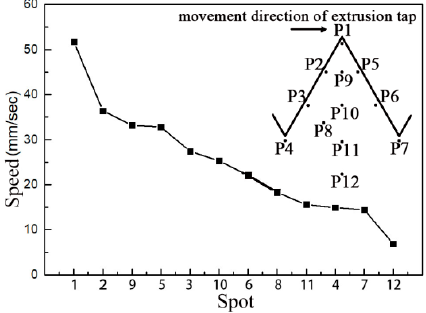
Figure 7. Velocity profile of each point on the thread surface.